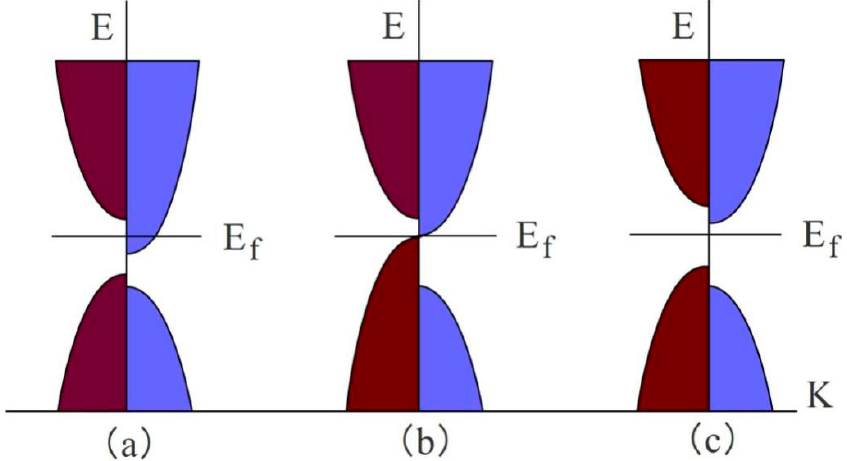
Figure 1. Schematics of the densities of states of a ( a ) half-metal (HM), ( b ) spin-gapless semiconductor (SGS), and ( c ) magnetic semiconductor (MS).